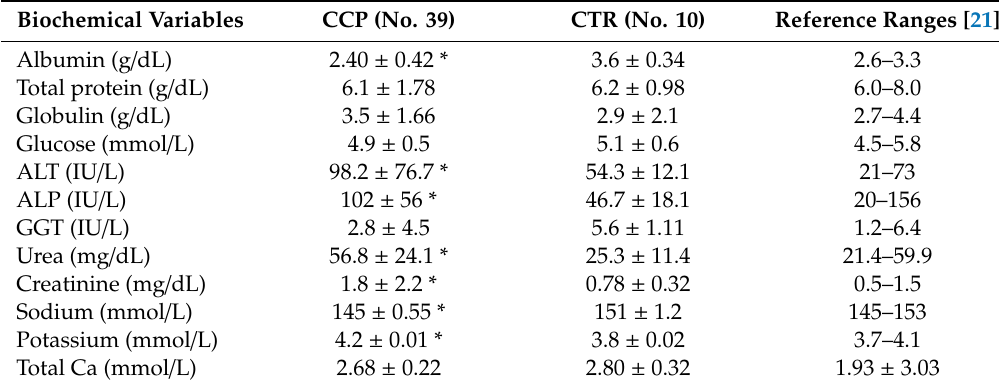
Table 2. Mean and standard deviation of biochemical variables analyzed for healthy bitches (CTR) and animals with closed cervix pyometra (CCP).